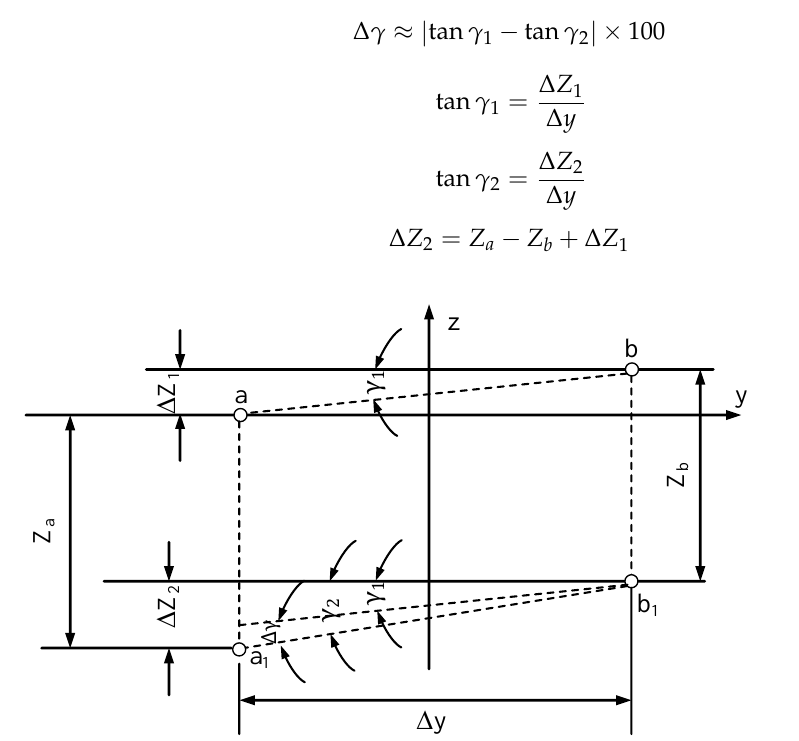
Figure 14. Schematic diagram of modified deformation gradient method.